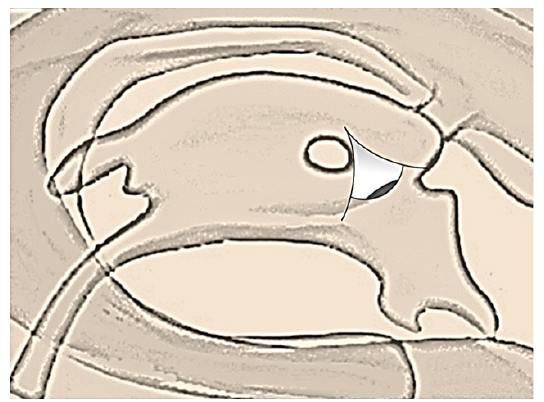
Fig. 14. Direction of the endoscopic viewing angle for the anterior segment of the third ventricle.